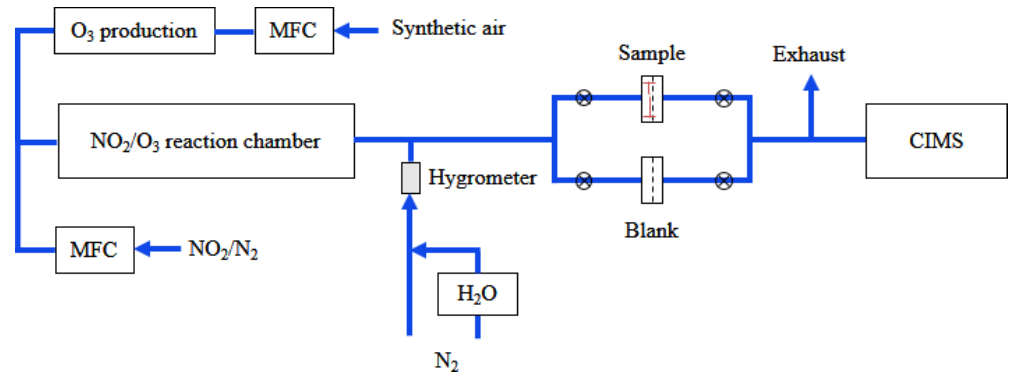
Figure 1. Schematic diagram of the experimental